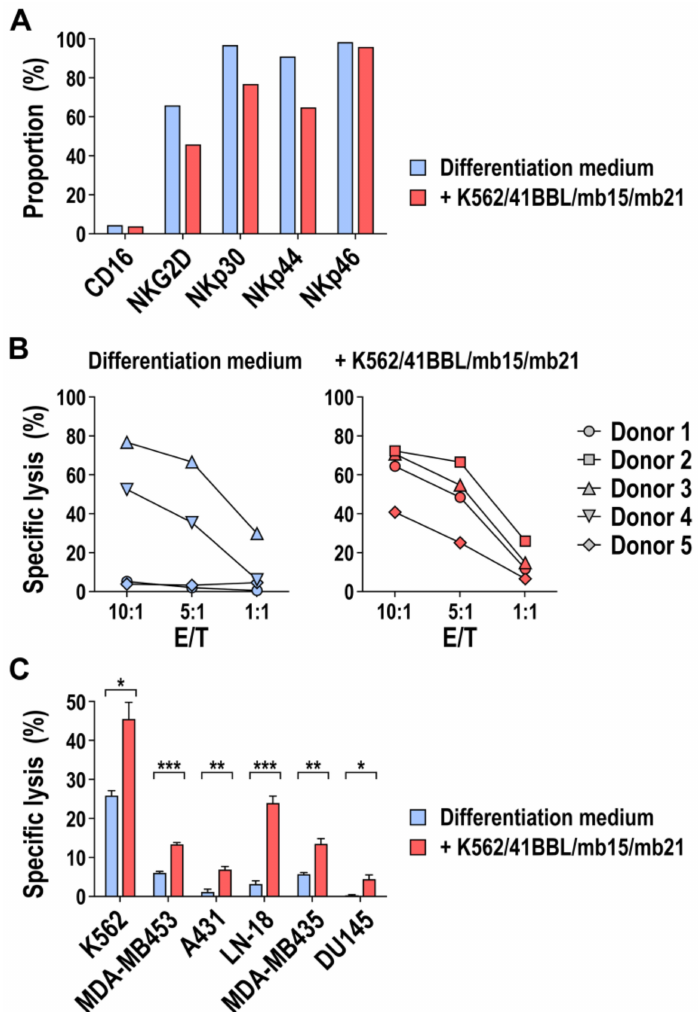
Figure 7. Phenotypic and functional characterization of ex-vivo-generated CD56 + NK cells co-cultured with K562 / 41BBL / mb15 / mb21 feeder cells. ( A ) Surface expression of NK-cell-associated activating receptors CD16, NKG2D, and NCRs (NKp30, NKp44, NKp46) by ex-vivo-generated CD56 + cells after co-culture with K562 / 41BBL / mb15 / mb21 feeder cells (red bars) or cultured in regular cytokine-containing medium (blue bars) was analyzed by flow cytometry. Results from a representative experiment are shown. ( B ) Cytotoxicity of CD56 + NK cells generated from PB-CD34 + cells using K562 / 41BBL / mb15 / mb21 feeder cells towards K562 leukemia cells was determined in flow-cytometry-based cell killing assays at di ff erent e ff ector to target (E / T) ratios (right panel). NK cells generated only using cytokine-containing medium were included as controls (left panel). Cells from donors 1, 3, and 5 were tested in parallel using both conditions, while cells from donors 2 and 4 were only expanded using K562 / 41BBL / mb15 / mb21 feeder cells or cytokine-containing medium, respectively. Mean values ± SEM of three technical replicates for each donor are shown. Donors are the same as for the experiments shown in Figure 3. ( C ) MDA-MB453 breast carcinoma, A431 squamous cell carcinoma, LN-18 glioblastoma, MDA-MB435 melanoma, and DU145 prostate cancer cells were co-incubated with CD56 + NK cells either generated with K562 / 41BBL / mb15 / mb21 feeder cells (red bars) or only with cytokine-containing medium (blue bars) for 2.5 h at an E / T ratio of 5:1, and NK-cell-mediated cytotoxicity was determined by flow cytometry. K562 leukemia cells were included for comparison. Mean values ± SEM of three technical replicates performed with the cells of a representative donor are shown; *** p < 0.001; ** p < 0.01; * p <